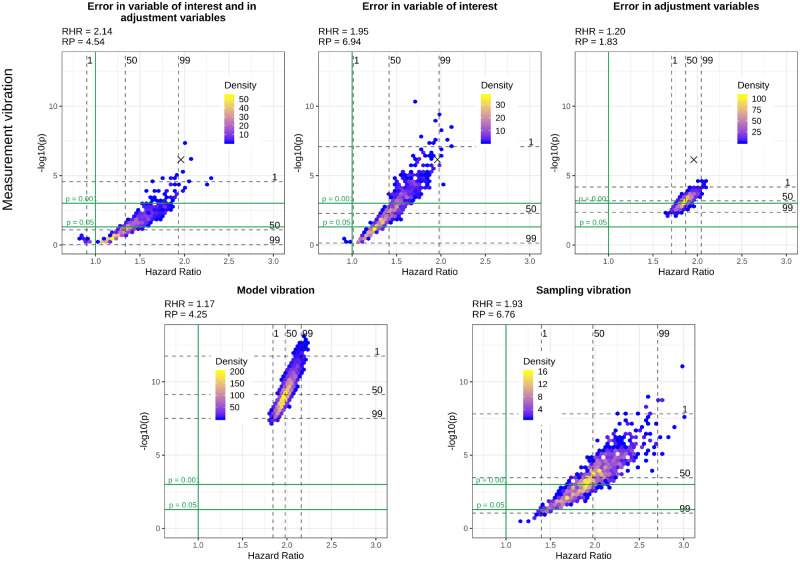
Volcano plots for different types of vibration and different scenarios of measurement vibration when heart disease is the variable of interest. The black cross in the top panel indicates the model without measurement error